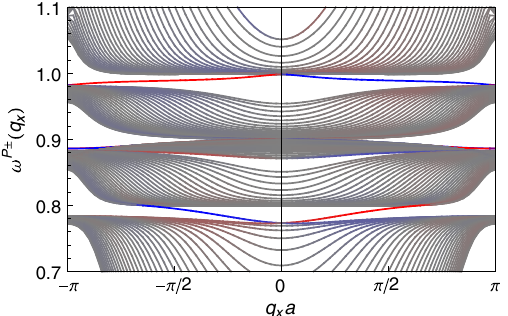
FIG. 6. Topological polariton spectrum with a periodic poten- tial. The spectrum is obtained for a finite-size lattice version of the Hamiltonian Eq. (1) with an additional periodic potential of period a and exhibits in-gap chiral edge modes (colored). The color scale encodes the edge localization, where red (blue) indicates a large weight of the wave function at the edge at y ¼ 0 ( y ¼ L ). The system size is 40 × 40 (with lattice constant a ¼ 1 ) and the other relevant parameters are given